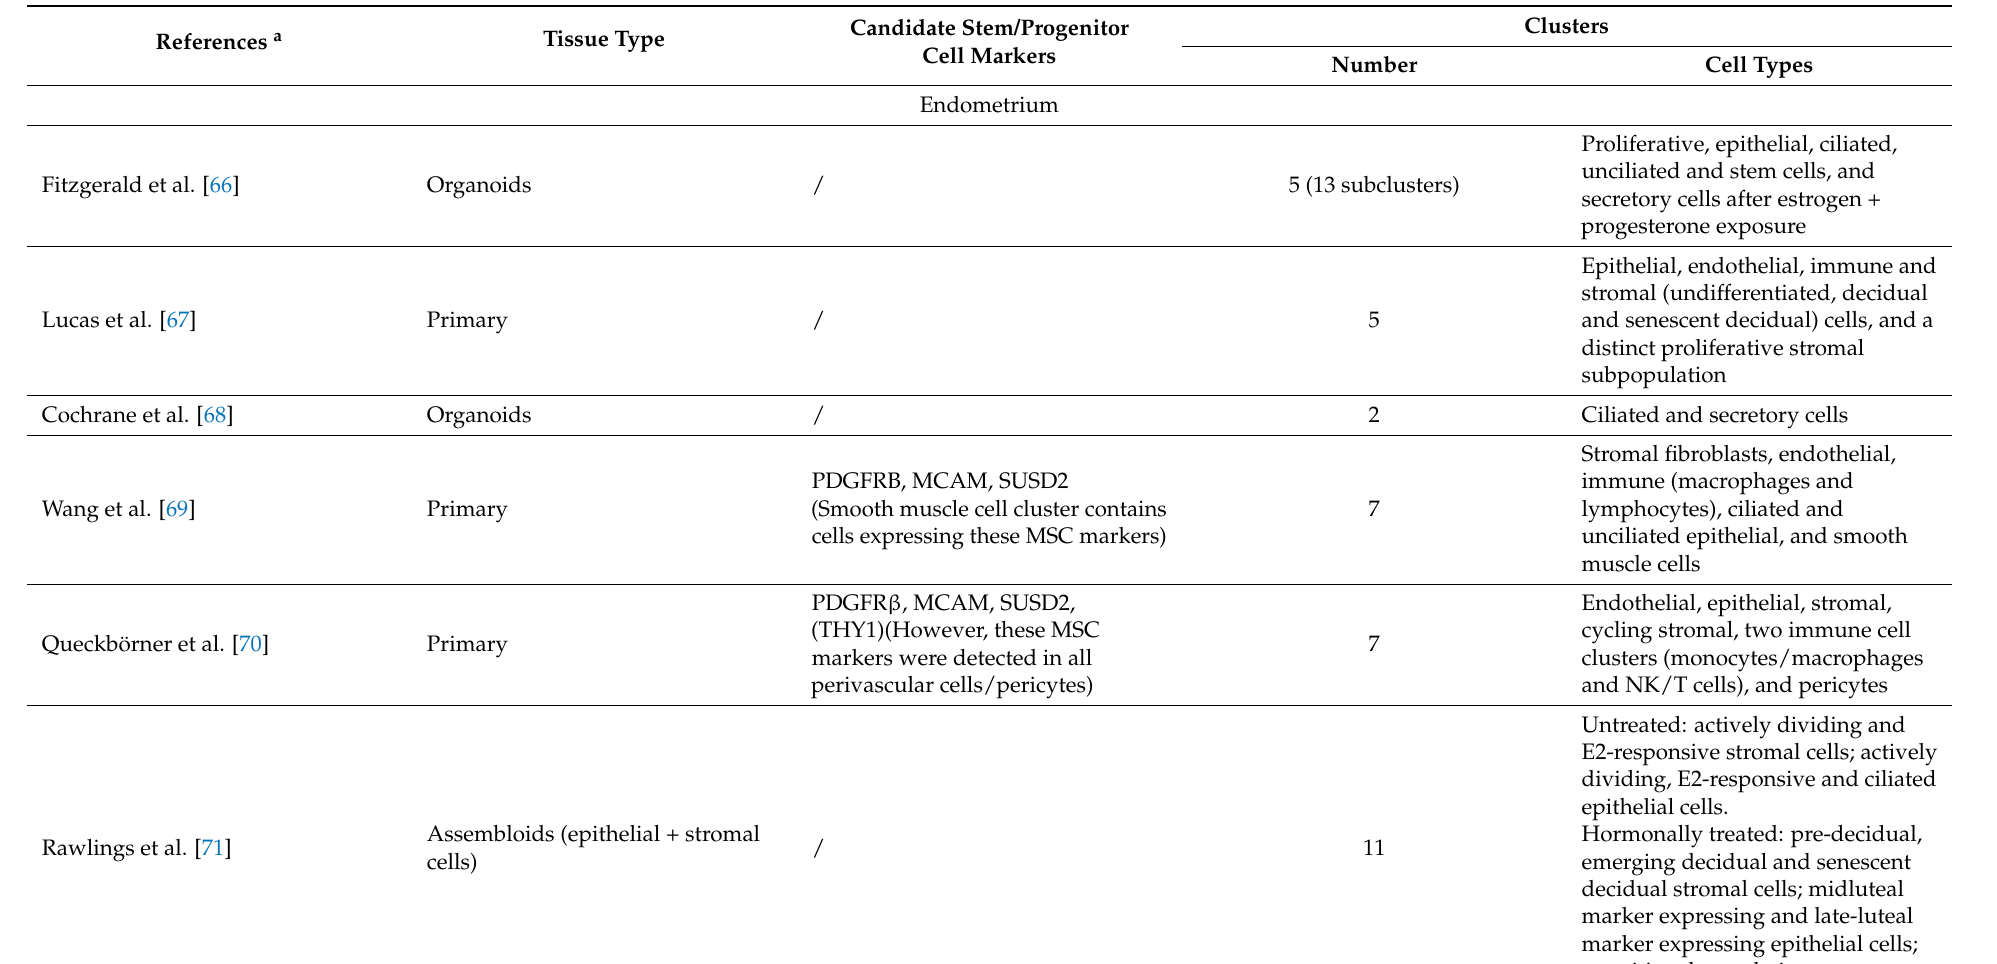
Table 2. Overview of single-cell profiling studies of the endometrium and endometriosis and derived candidate stem/progenitor